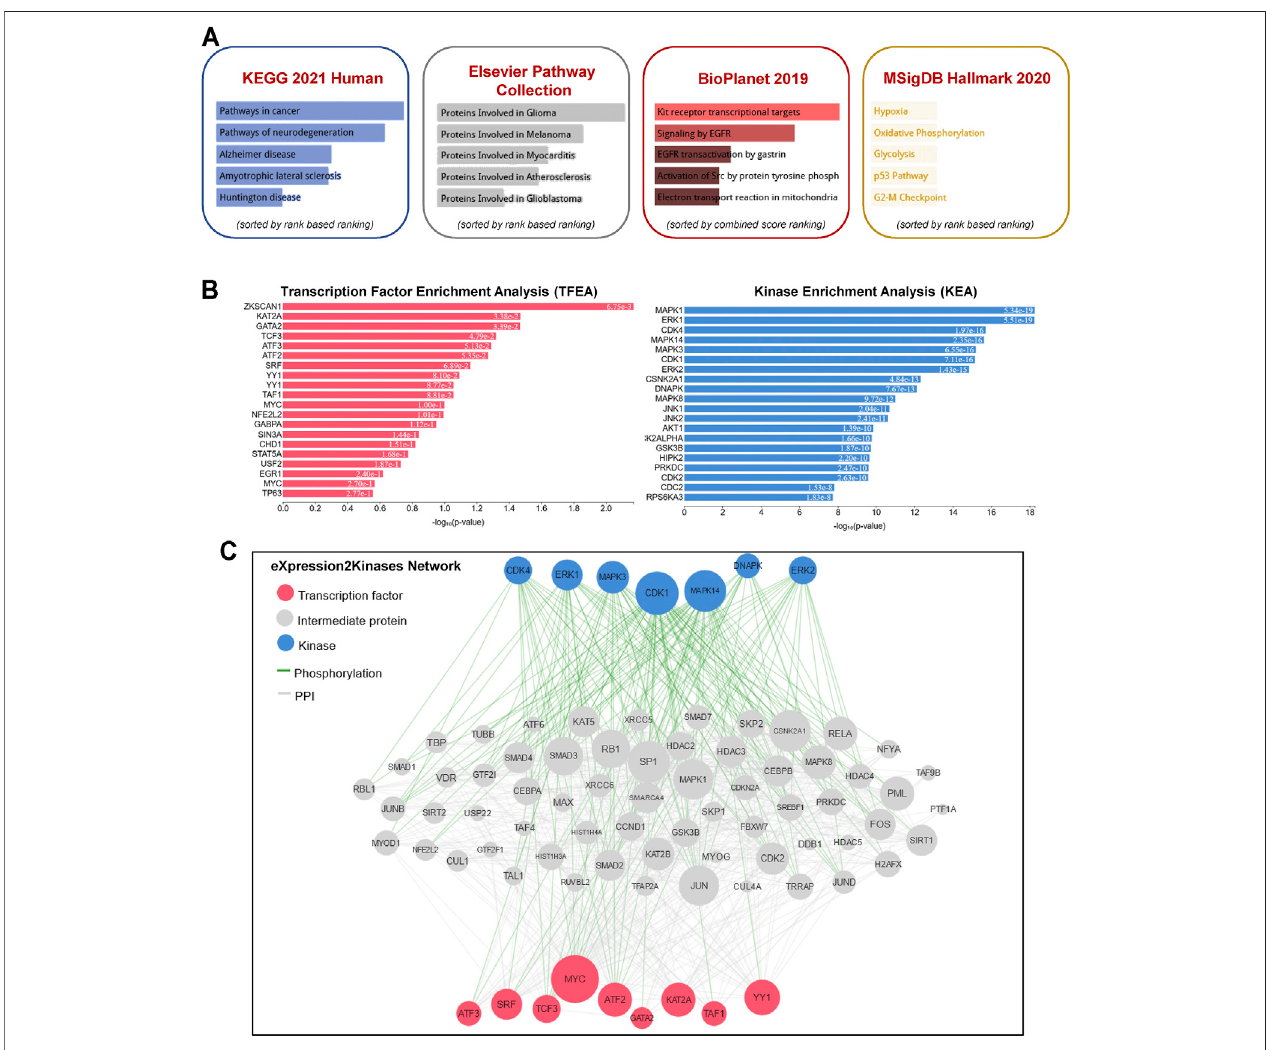
FIGURE 2 | Pathway enrichment analysis and eXpression2Kinases network. (A) A comprehensive gene set enrichment analysis for the cis - and trans -regulatory target genes of differentially expressed lncRNAs was performed using EnrichR 2021 and the 2021 Kyoto Encyclopedia of Genes and Genomes (KEGG) Human database, Elsevier Pathway Collection, BioPlanet 2019, and the Molecular Signatures Database 2020 (MsigDB). (B) Transcription factor enrichment analysis (left panel) and kinase enrichment (right panel) analyses are shown for all the cis- and trans- regulatory target genes of differentially expressed lncRNAs. (C) The eXpression2Kinases (X2K) network displays the inferred upstream regulatory network predicted to regulate the input list of genes by integrating the results from the TFEA, the network expansion, and the kinase enrichment. Pink nodes represent the top transcription factors predicted to regulate the expression of the input gene list; blue nodes represent the top predicted protein kinases known to phosphorylate the proteins within the expanded subnetwork. Green network edges/links represent kinase-substrate phosphorylation interactions between kinases and their substrates, while grey network edges represent physical protein-protein interactions.